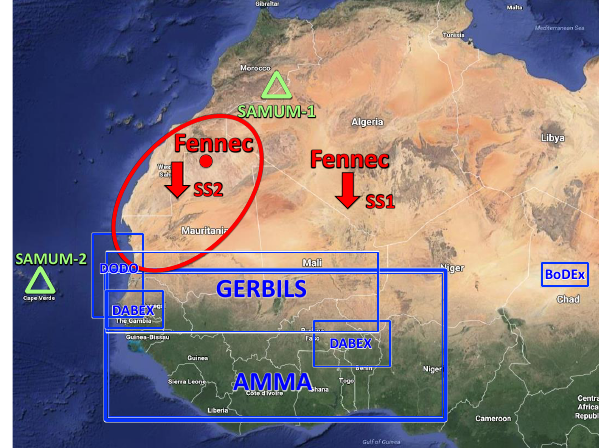
Figure 1. Northwestern Africa showing areas of operation of three major families of dust field campaigns. AMMA, DABEX, DODO, and BoDEx are indicated by blue boxes. SAMUM exper- iments are shown by green triangles. Fennec shown by red arrows point to the location of Fennec Supersite 1 (SS1) in Bordj Badji Mokhtar in Algeria and Fennec Supersite 2 (SS2) in Mauritania, in the city of Zouérat (main location). The red dot marks the city of Bir Moghrein, Mauritania, where the second LACO aerosol sam- pling station was deployed during the Fennec